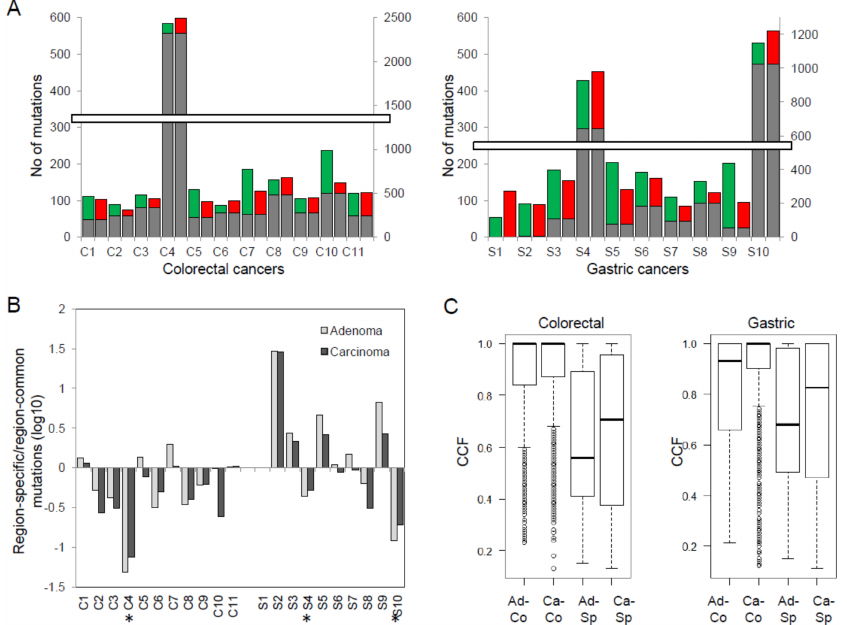
Figure 1. Exonic mutations of colorectal and gastric pairs of adenoma and carcinoma. ( A ) Mutational abundance (i.e., the number of exonic mutations) is shown for 21 pairs of adenoma and carcinoma (11 colorectal and 10 gastric; left and right, respectively). Lesion-common (gray) mutations are distinguished from adenoma-specific and carcinoma-specific mutations (green and red, respectively). ( B ) For each lesion (gray and black for adenomas and carcinomas, respectively), the ratio of lesion-specific and lesion-common mutations are shown (log-scaled; y -axis). Dominance of lesion-specific mutations over lesion-common mutations is shown as positive log-ratios. Asterisks indicate the three hypermutated cases. ( C ) cancer cell fractions (CCFs) are shown as mutation allele frequencies adjusted for estimated tumor purity and ploidy levels. Ad-Co and Ca-Co mutations are lesion-common mutations of adenomas and carcinomas, respectively. Ad-Sp and Ca-Sp mutations are for those of adenoma- and carcinoma-specific